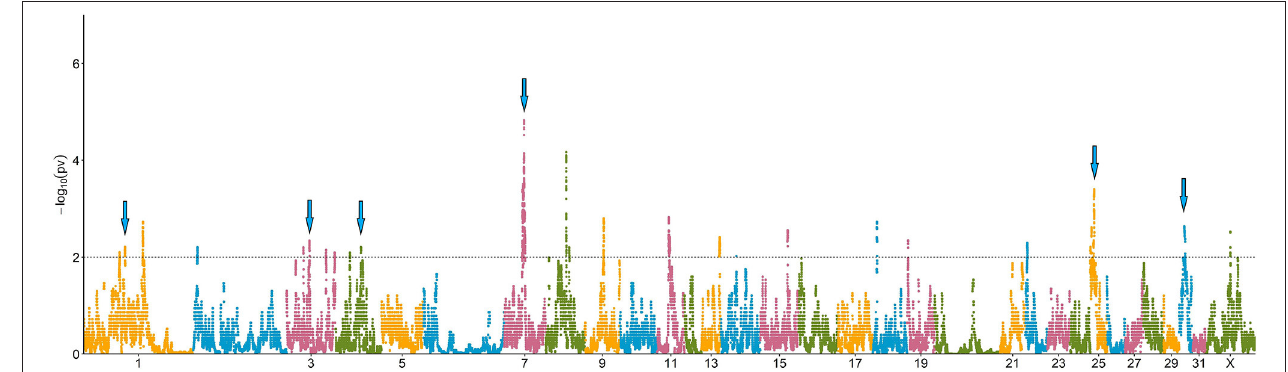
FIGURE 4 | Manhattan plot depicting the incidence of ROH per marker (estimated as -log 10 ( p -value) using a permutation test). Significance was set at a 100-fold increase (dotted line). Cyan arrows show ROHi statistically associated with Re after validation.